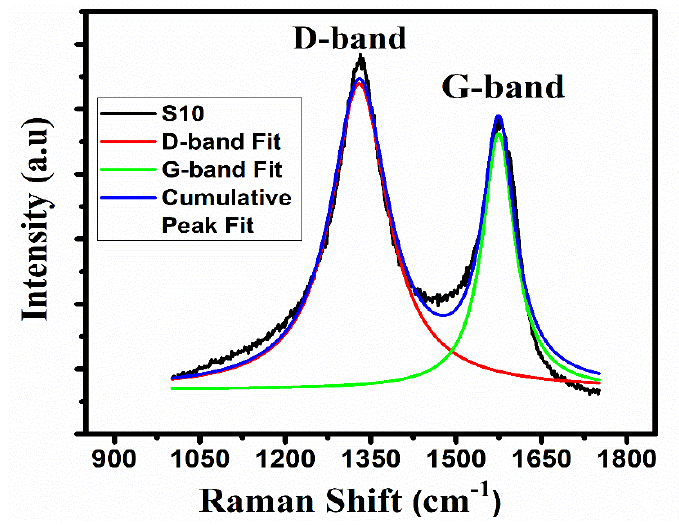
Figure 4. Raman spectrum for the sample a-carbon films.